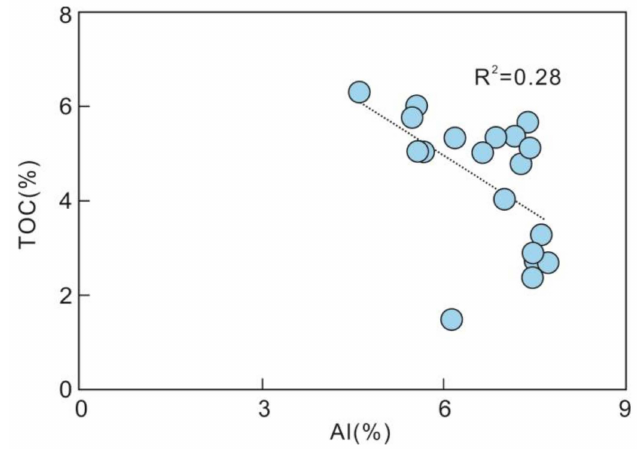
Figure 9. Crossplot of Al vs. TOC for the Meizwan